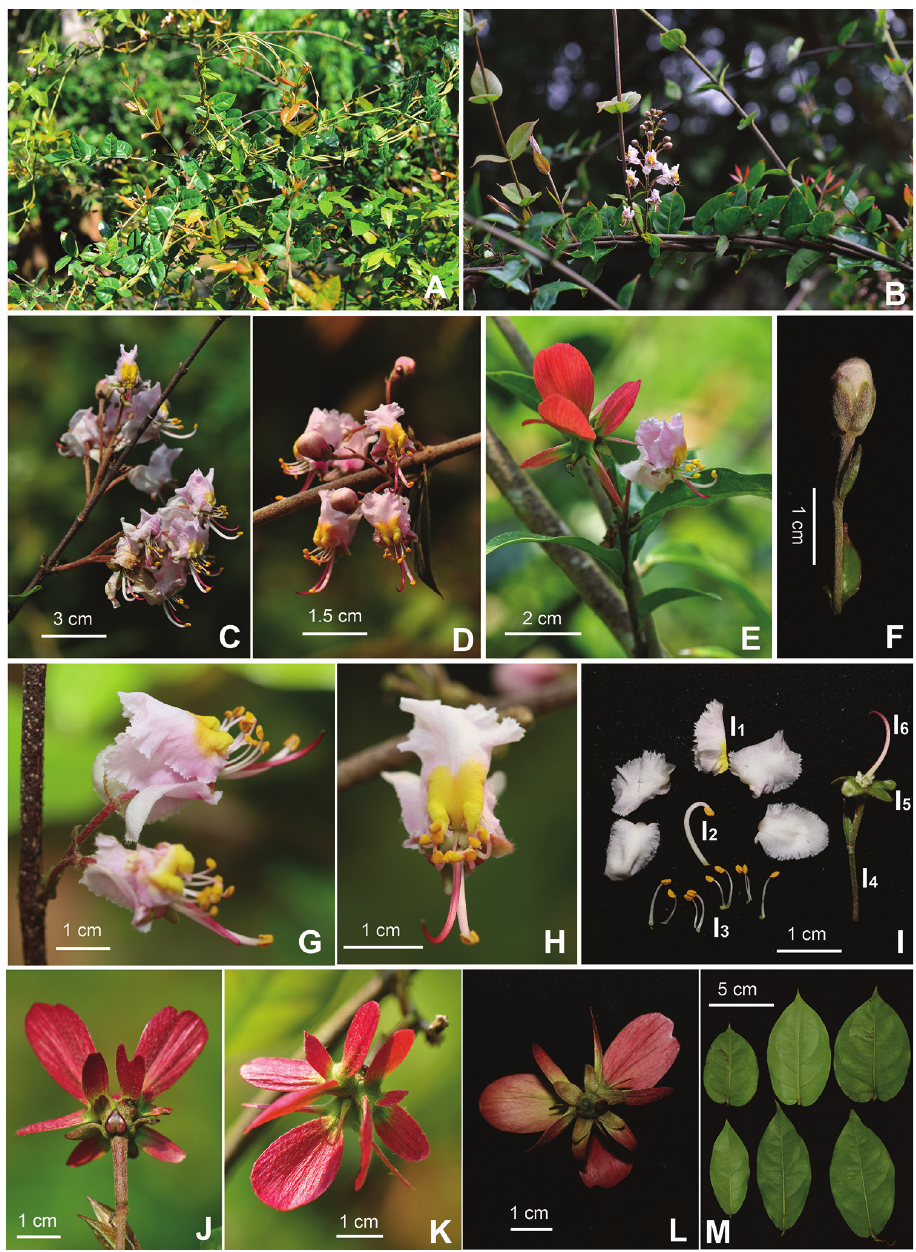
Figure 1. Hiptage pauciflora Y.H.Tan & Bin Yang, sp. nov. A, B Habit C Inflorescence (lateral view) D Inflorescence (frontal view) E Flowering branch F Flower bud G Flowers (lateral view) H Flower (frontal view) I Flower (I1 Petals; I2 the longest stamen; I3 the 9 short stamens; I4 Pedicel; I5 Calyx; I6 Style) J Samaras (lateral view and showing calyx gland) K Samaras (vertical view) L Samaras (dorsal view) M Leaves (adaxial view). Photographed by Y.H. Tan, H.B. Ding and B.